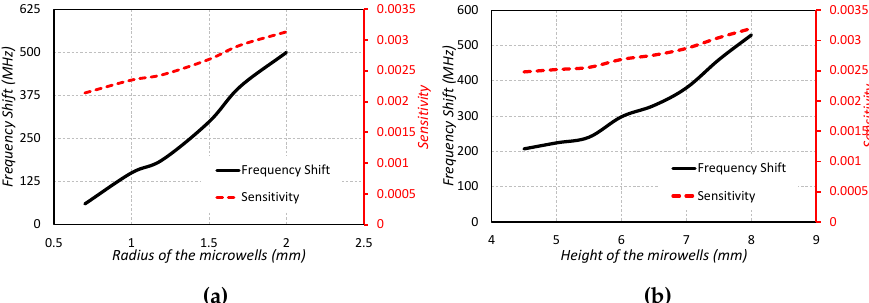
Figure 8. Type2: Frequency shift and sensitivity against ( a ) Radius of the microwells ( b ) Height of the microwells.